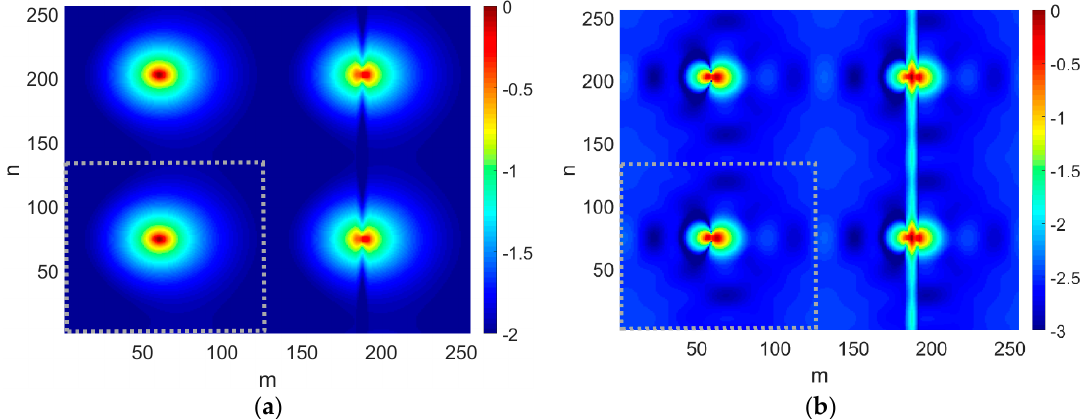
Figure 5. Normalized values of discrete functions f d,indj,q, y [ m,n ] and f d,capj,q [ m,n ] given in Equations (22) and (23) associated with BF defined on adjacent Bézier located on central region of upper ellipse half (i.e., when j = 102). The results are obtained at 10 GHz for L 1 = 4.1365 mm under oblique incidence given by = 20 deg and φ = 0 deg.( a ) Log | f d,ind / f d,ind | . ( b ) Log | f d,cap / f d,cap | θ inc inc 10 j,q,y [m,n] j,q,y,max 10 j,q [m,n] j,q,max